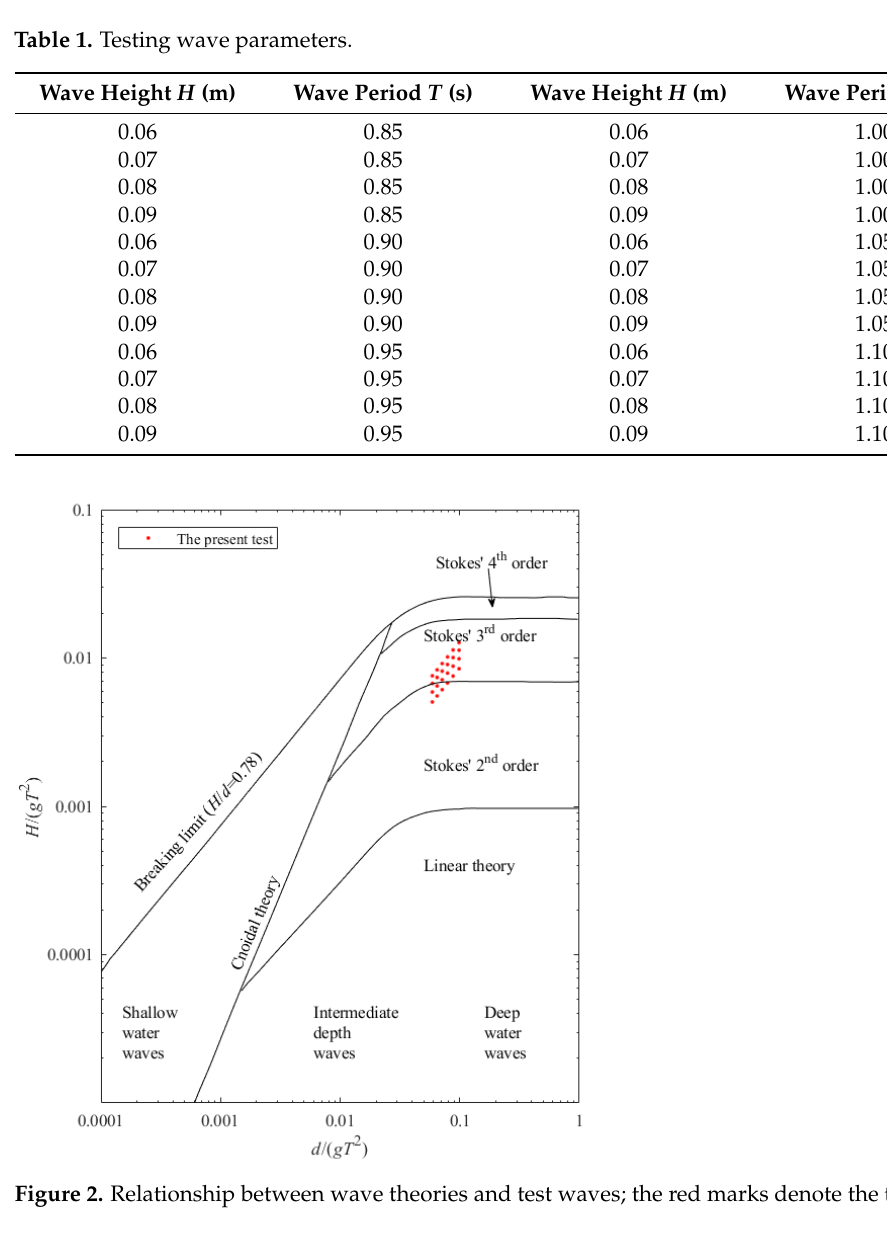
Table 1. Testing wave parameters.